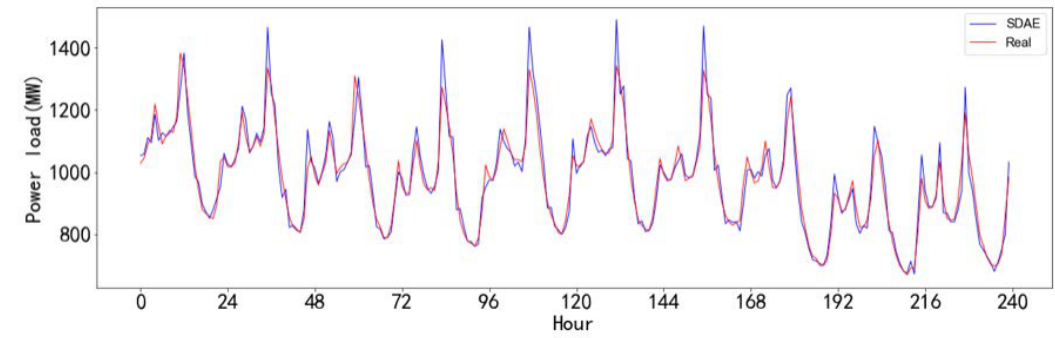
Figure 8. Fitting results of the SDAE-based model.